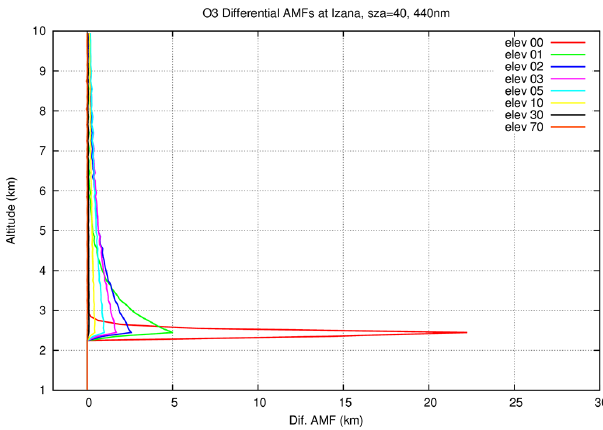
Figure 2. Horizontal optical paths obtained from the SPDISORT solver when single (green diamonds) and multiple (red diamonds) scattering are considered. The blue diamonds correspond to the dif- ferences between the single and multiple scattering paths.